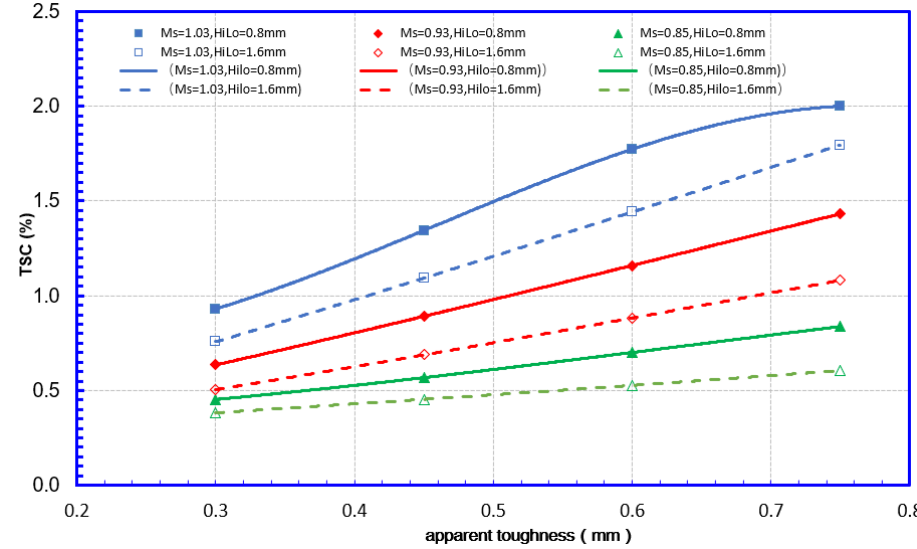
Figure 15. Mismatch and toughness effects on TSC 12.8 mm—12.8 mm WT.